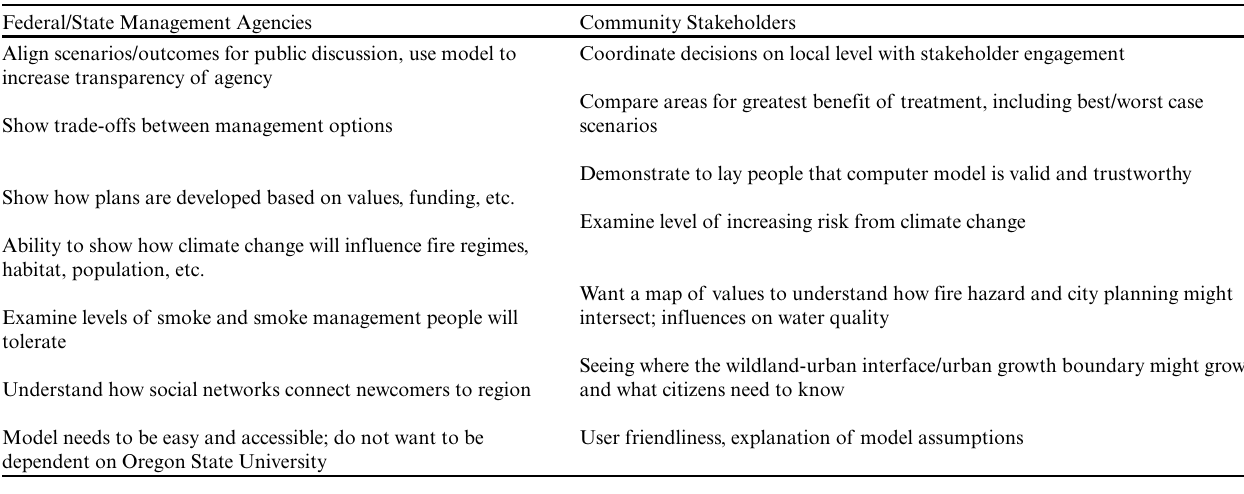
Table 2 . Examples of interests of agencies and stakeholders in application of the ENVISION model. Federal/State Management